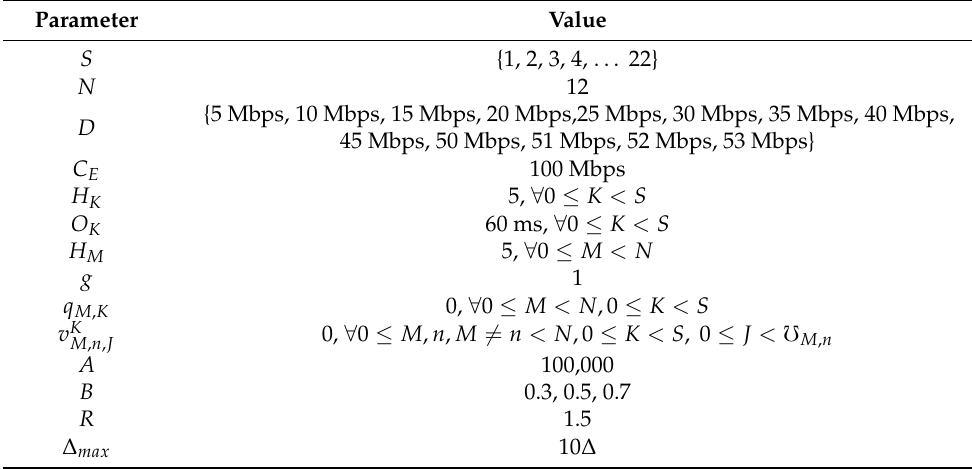
Table 3. Initial Network Configuration